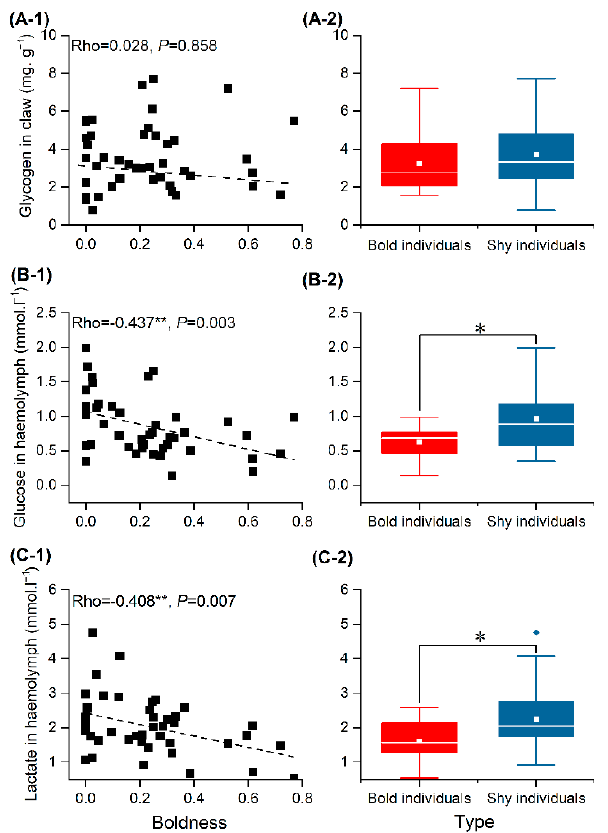
Figure 5. Correlation analysis between boldness and glycogen ( A-1 ) in cheliped muscle, glucose ( B-1